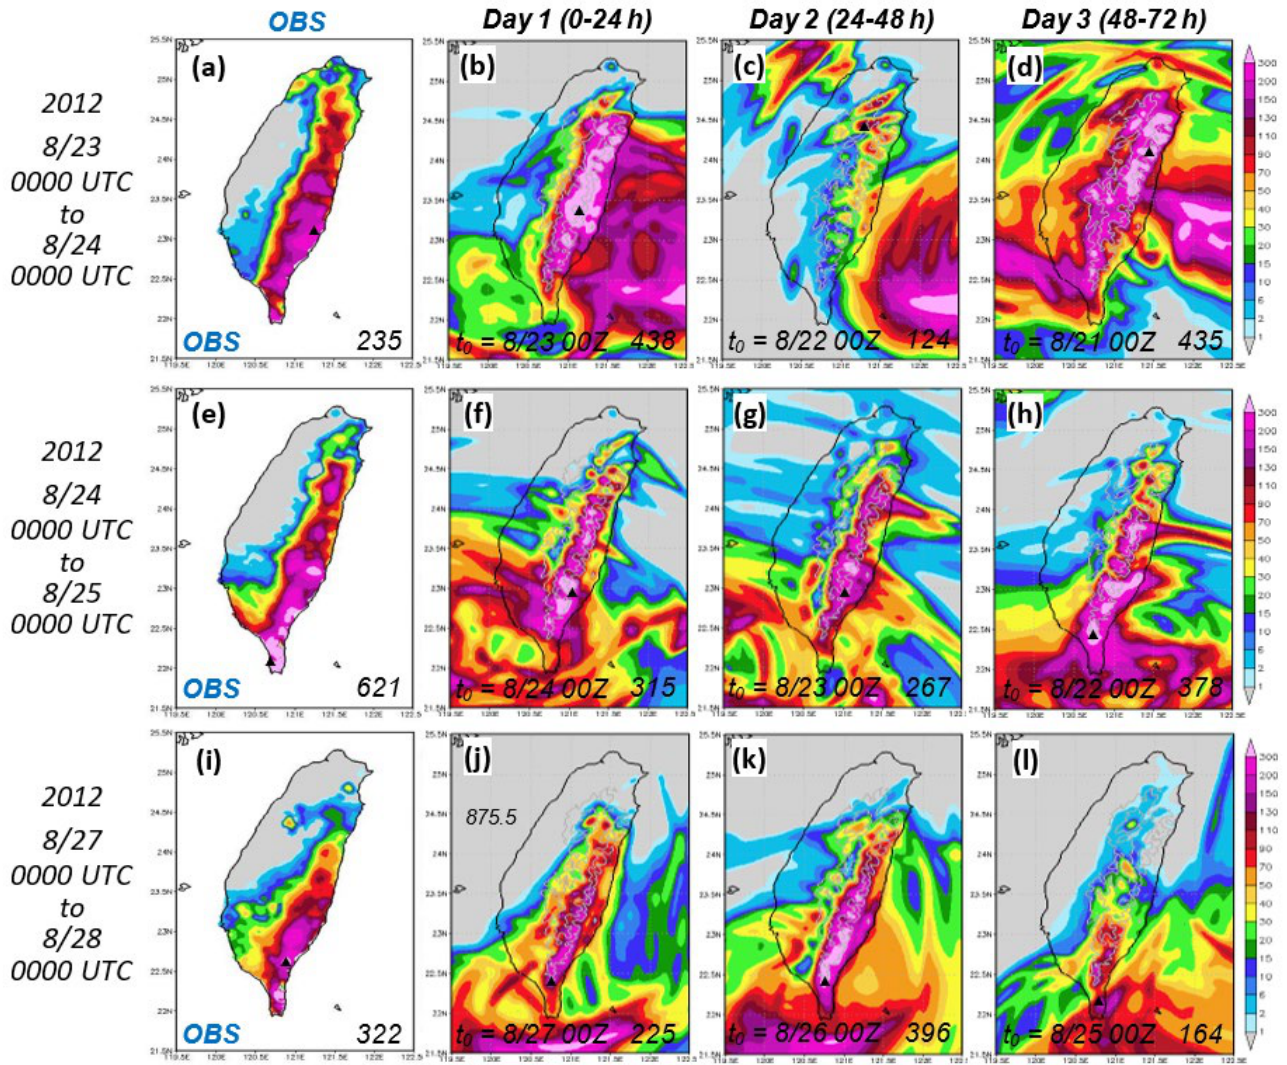
Figure 9. As in Figure 7, except for the rainfall distribution (mm) in observation and CReSS QPFs at ranges of days 1–3, valid for the 24 h period starting from 0000 UTC of ( a – d ) 23 August, ( e – h ) 24 August, and ( i – l ) 27 August, respectively, during TY Tembin